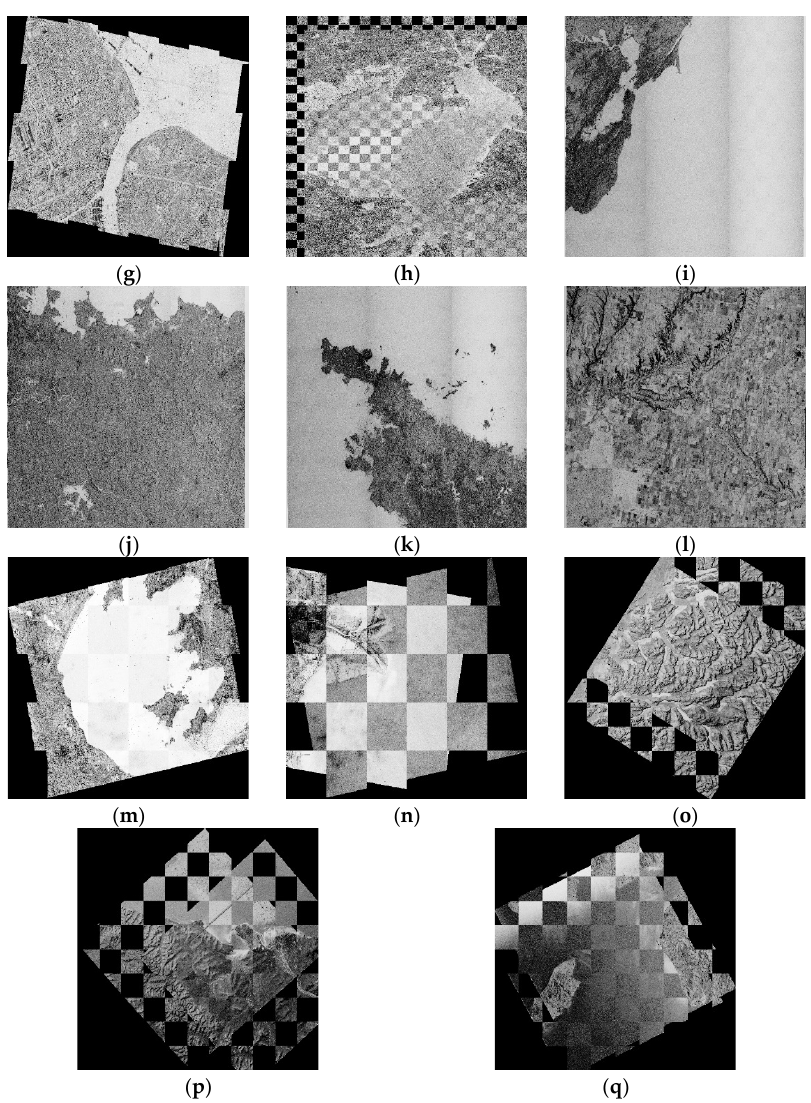
Figure 10. The checkerboard mosaic images ( a – q ) of datasets 1–17.